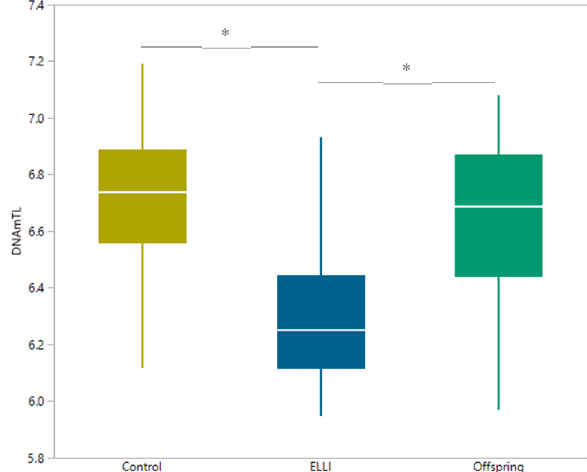
Figure 6. DNAmTL calculated using the online tool. DNAmTL was calculated by applying methylation beta values of 140 CpGs to online tool [37]. N control = 28, N ELLI = 24, and N offspring = 18. * Significant differences, p <0.05.